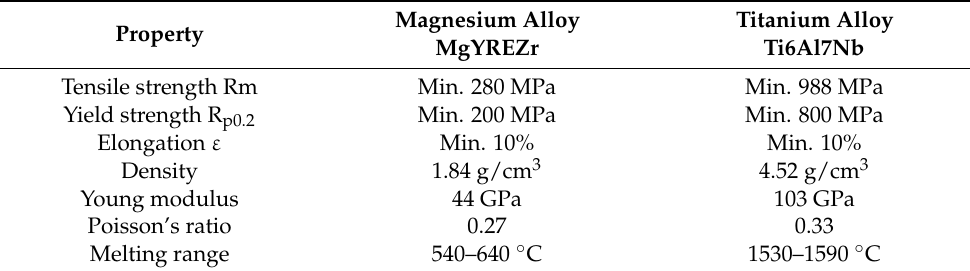
Table 3. Physical properties of the materials used in the experiment (see Table